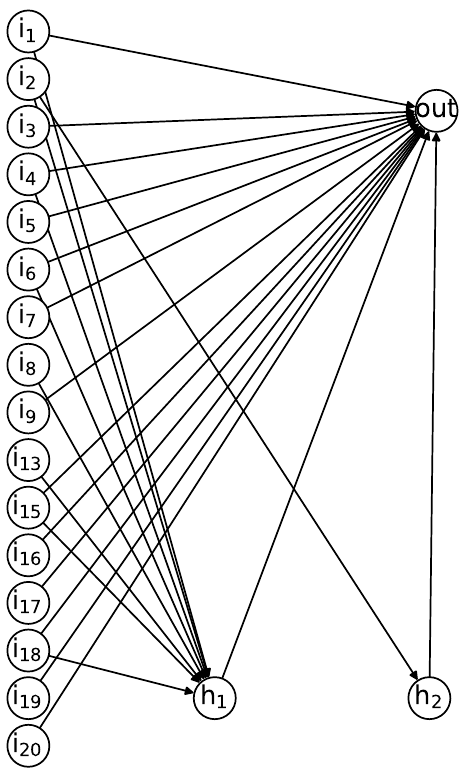
Figure 7. Trade-off between test RMSE and number of trainable parameters for the methods consid- ered in the experimentation on N-CMAPSS (DS02).